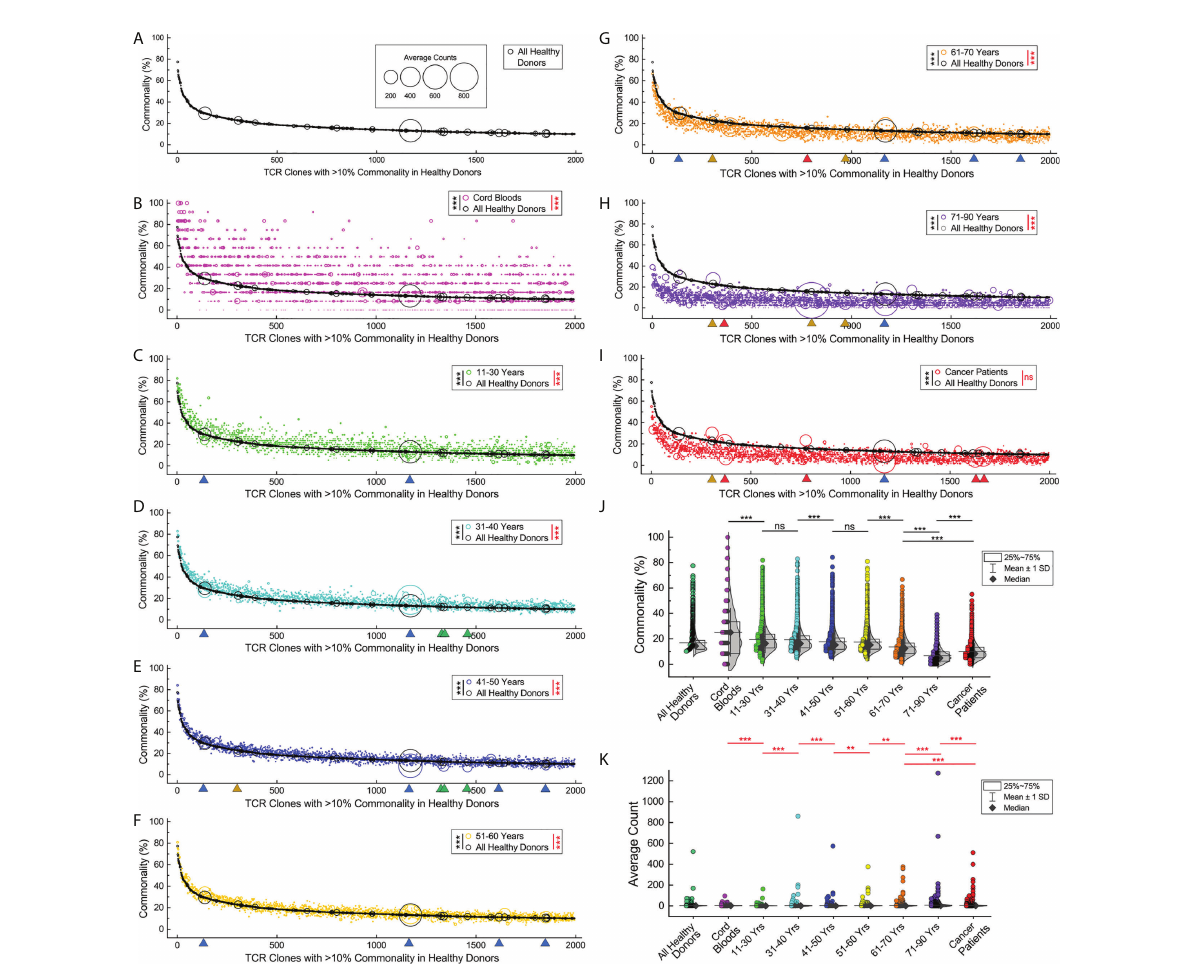
FIGURE 4 Loss of shared common TCR b clones and clone expansions in elder individuals and cancer patients. (A) . Commonalities and expansions of the high-commonality TCR b clones (HCTCs) in overall healthy donors. The HCTCs are sorted by their commonalities (x-axis, from high to low). The y ‐ axis indicates the commonality of each clone type. The area of each symbol represents average clone size of a given clone type (count summary of TCR b sequences relevant to a given CDR3 clone type in a given subgroup, divided by the times the clone type appears in the subgroup). (B) Commonalities and expansions of HCTCs in cord blood samples (magenta symbols) and overall healthy donors (black symbols). (C – H) . Commonalities and expansions of HCTCs in healthy donors of different age groups. Green triangles indicate representative clones signi fi cantly expanding in younger age groups, while orange or red triangles indicate clones expanding in the elder age groups or cancer patients, and blue triangles indicate clones universally expanding. (I) Commonalities and expansions of HCTCs in cancer patients (red symbols). (J) Comparison of commonalities of the HCTCs in healthy donors of different age groups, cancer patients, and cord blood samples. (K) Comparison of average clone sizes of the HCTCs in healthy donors of different age groups, cancer patients, and cord blood samples. The asterisks beside the panel legends indicate the comparison of commonalities (black asterisks) and average clone sizes (red asterisks) by Wilcoxon signed ranks test (** p < 0.01; *** p < 0.001). ns, not signi fi